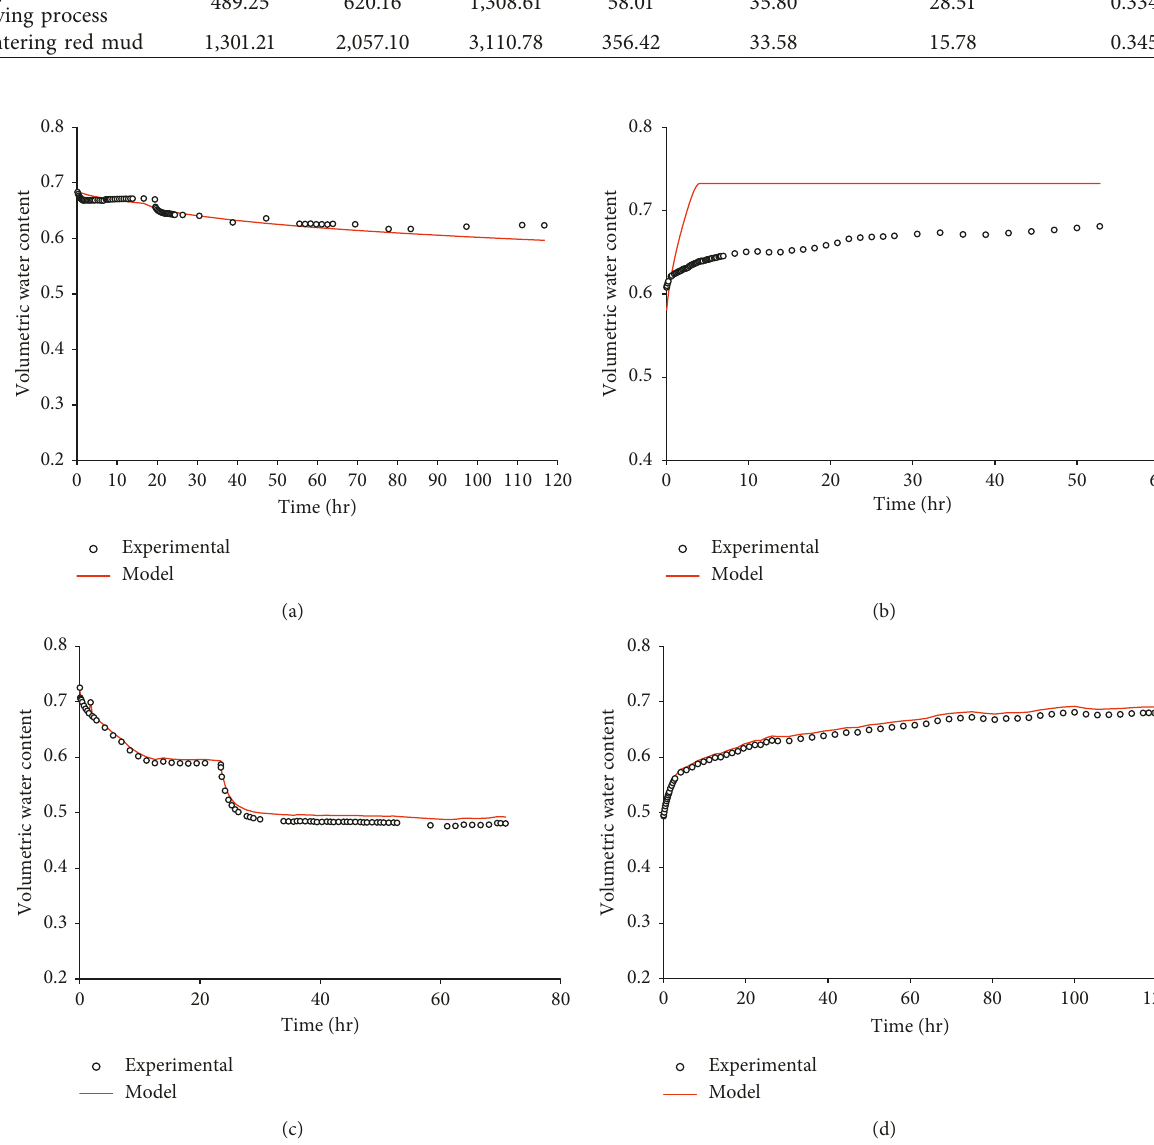
Figure 7: Comparison of fitting value and actual value of relation curve between red mud volumetric water content and time under moisture desorption-moisture absorption hydraulic path conditions. (a) Moisture desorption test stage of sintering red mud. (b) Moisture absorption test stage of sintering red mud. (c) Moisture desorption test stage of Bayer red mud. (d) Moisture absorption test stage of Bayer red